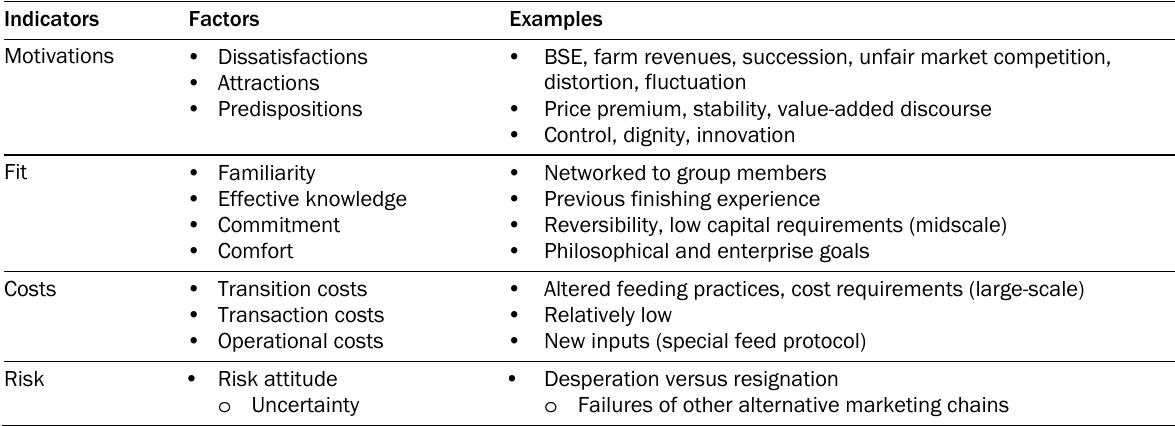
Table 4. Relative Advantage in Intermediary-led Chains